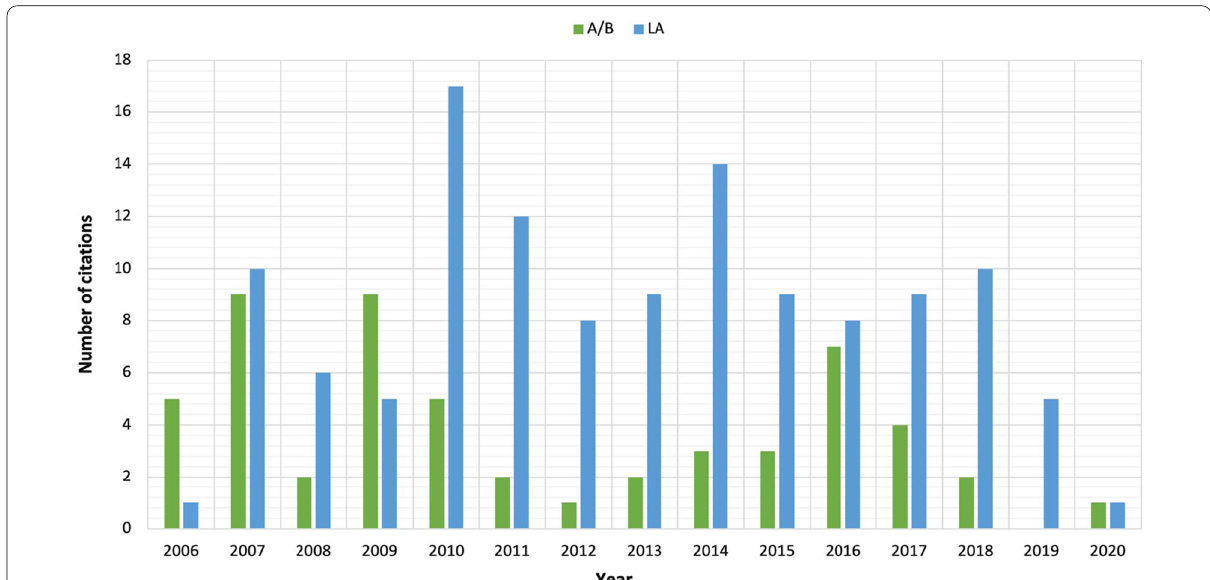
Fig. 1 The time series of the citations by year for the two